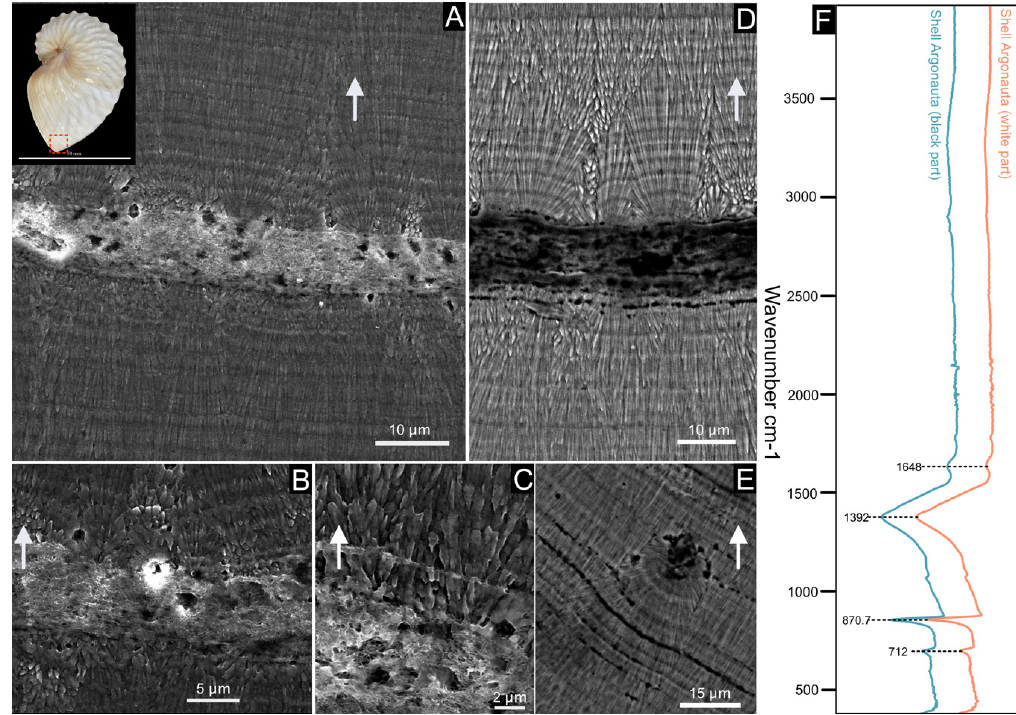
Figure 2. Shell microstructure of Argonauta hians . The localization of the following pictures is indicated in the shell, illustrated at the left top corner of the figure. ( A ) General view of the shell wall, showing two layers of fibrous calcite separated by a central core. ( B , C ) Close-up view of the interface between the central core and the calcitic layers, showing the gradual transition from a spherulite into fibers ( C ). ( D ) Magnification of the central core (in back-scattered electron mode), which appears darker than the two calcitic layers. This suggests a higher content of organic material. ( E ) Illustration of a depositional accident, showing the re-initialization of the mineralization from a spherulite to fibers. ( F ) FT-IR spectra of the shell powder of the white and black parts of the keel. The white arrows indicate the exterior of the shell.